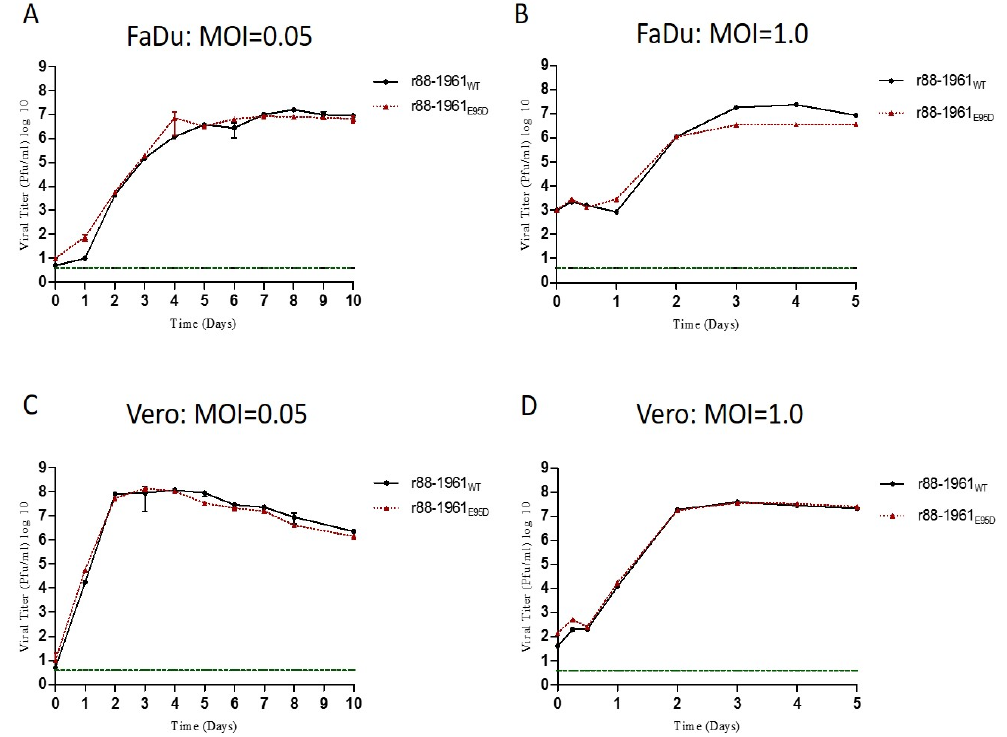
Figure 1. Comparison of the in vitro growth kinetics of r88-1961 WT versus r88-1961 E95D . Confluent monolayers of FaDu ( A , B ) and Vero cells ( C , D ) were infected with r88-1961 WT or r88-1961 E95D at an MOI of 0.05 ( A , C ) or 1.0 ( B , D ), and cumulative virus production was determined. The data represents mean values ± standard error of the mean from two independent experiments. The dashed horizontal line in each graph indicates the limit of detection of the assay. Similar growth kinetics and titers were observed between the two viruses tested in the same culture systems /